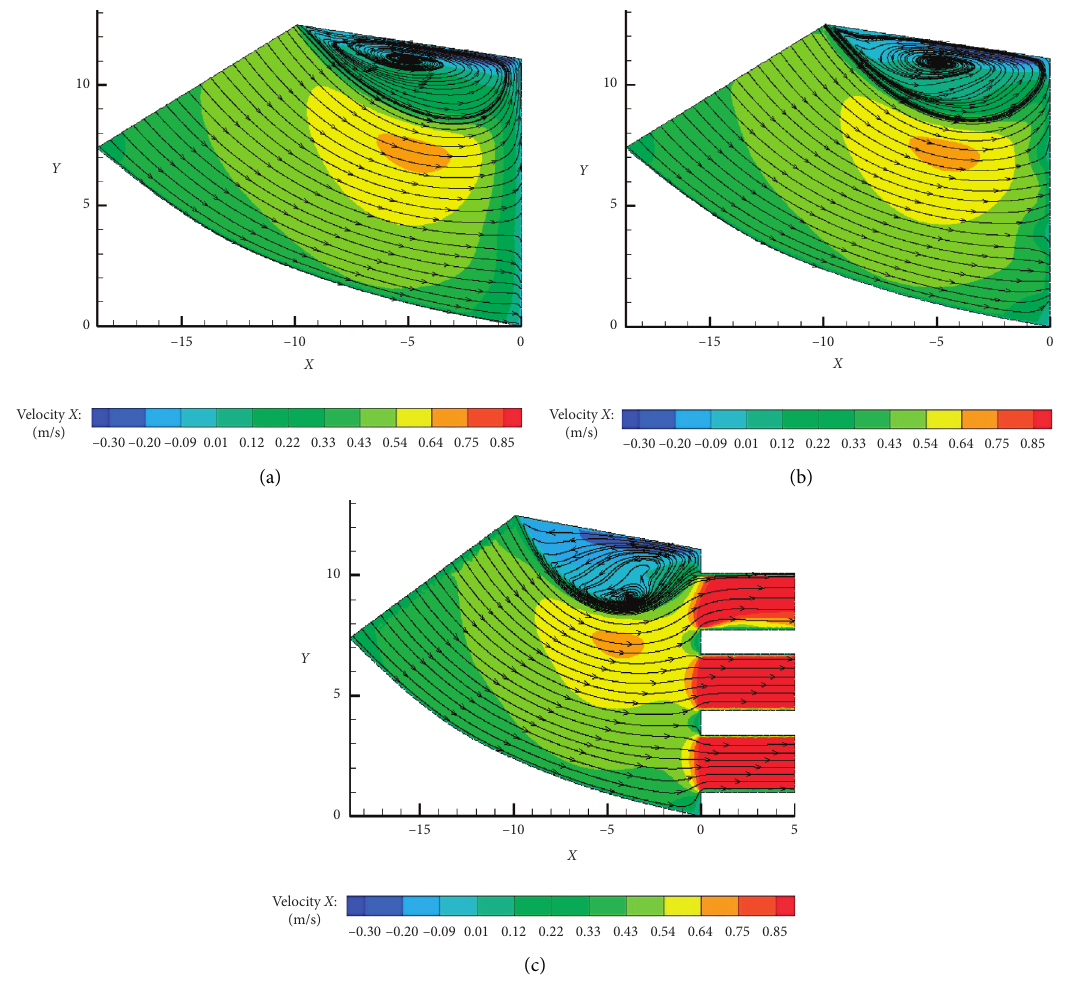
Figure 10: Velocity cloud diagram of the flow field in each horizontal section at a 60 ° lateral angle. (a) Surface velocity flow field diagram. (b) Midlevel velocity flow field diagram. (c) Bottom velocity flow field diagram.